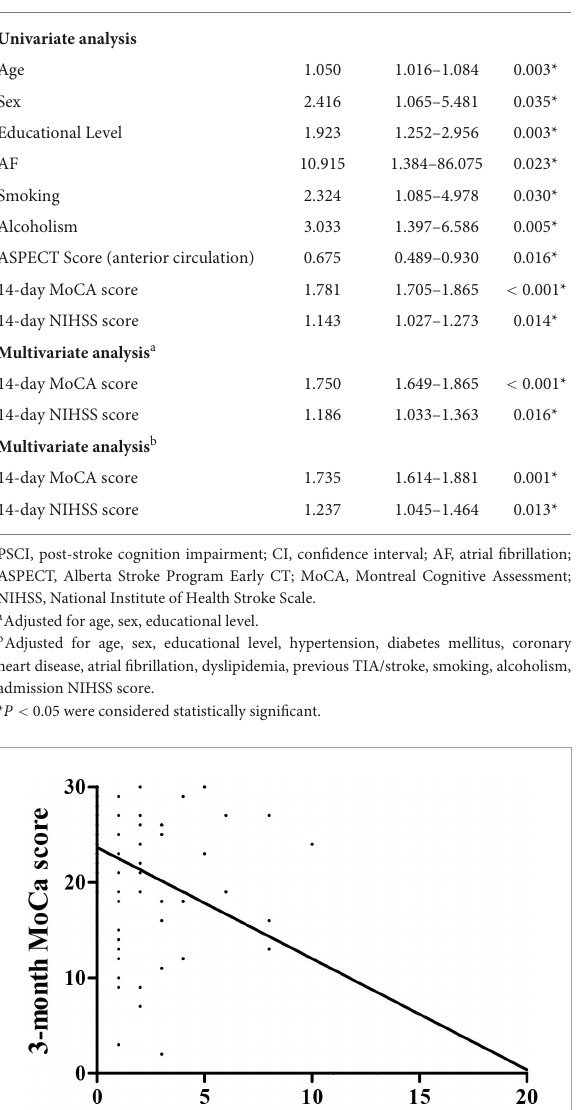
TABLE 2 Univariate analysis and multivariate analysis of predictors of post-stroke cognitive impairment (PSCI). Odds ratio 95% CI P -value